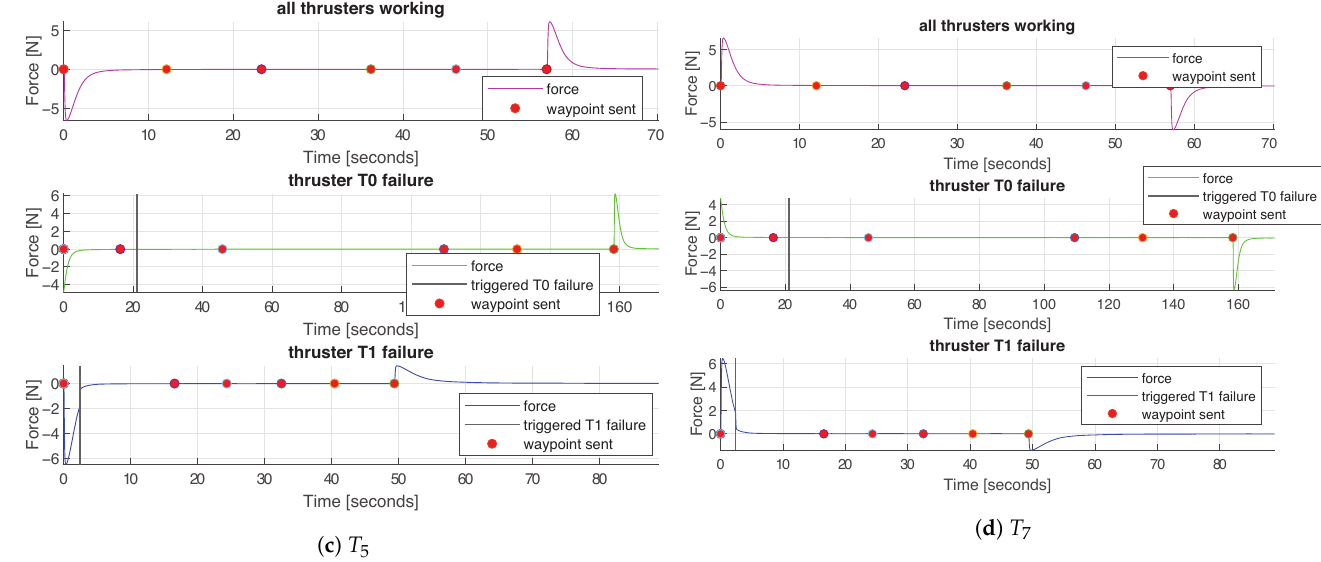
Figure 12. Forces produced by thrusters in charge for heave movement in all three experiments. Purple graphs represent the I test, green the II and blue the III . The time instance when each waypoint is sent is depicted with a red circle, and the moment of the thruster failure is depicted with a vertical black line.